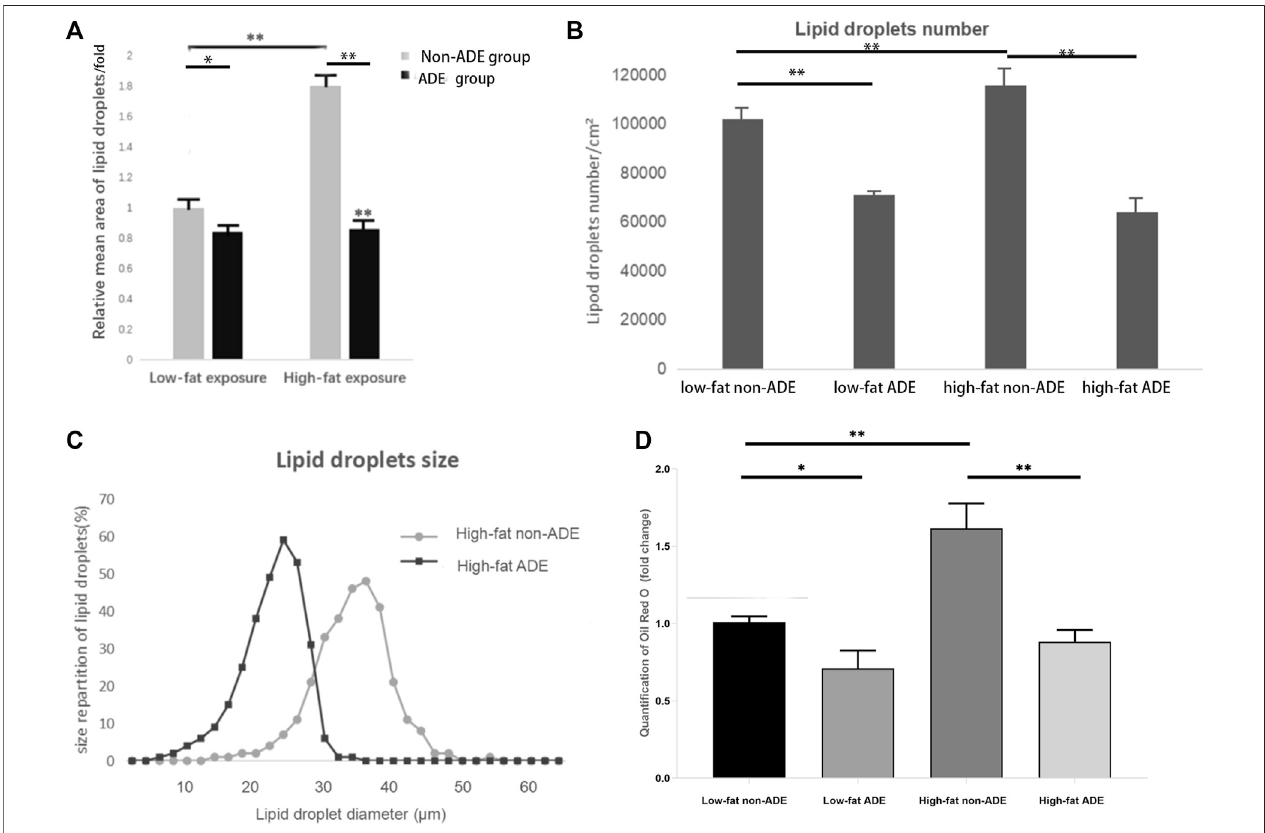
FIGURE 7 | Comparison of lipid droplets between groups. (A) Mean size of at least 300 lipid droplets randomly chosen per condition were determined using ImageJ. (B) Meannumberoflipiddropletspercm 2 . (C) Surfaceareaofatleast300lipiddroplets. (D) Quanti fi cationofOilRedO(foldchange).* p < 0.05and** p < 0.001.